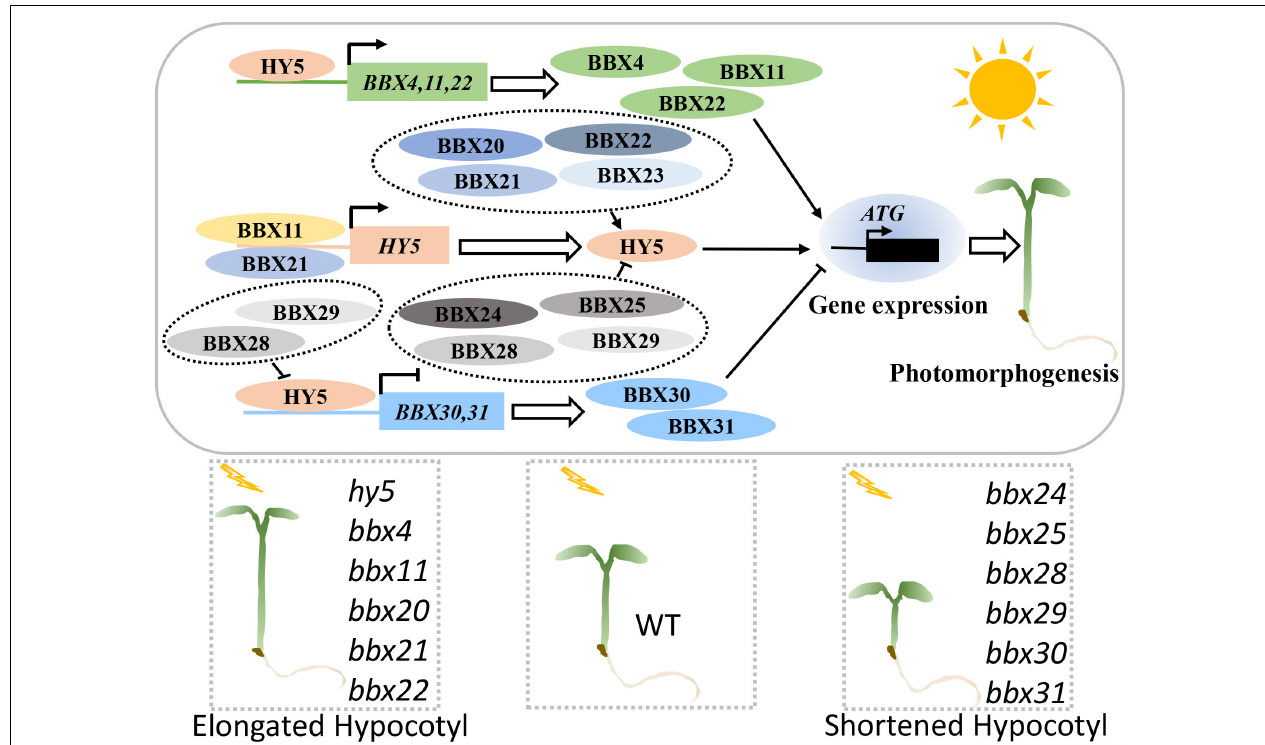
FIGURE 3 | BBX-HY5 regulatory module promotes photomorphogenesis. BBXs and HY5 form a complex transcriptionally regulatory network in promoting photomorphogenesis. HY5 activates the expression of BBX4 , BBX11, and BBX22 . BBX11 and BBX21 positively control the transcription of HY5 . BBX20, BBX21, BBX22, and BBX23 form heterodimers with HY5 to enhance its activity, whereas BBX24, BBX25, BBX28, and BBX29 interact with HY5 to inhibit its transcriptional activation activity. BBX28 and BBX29 inhibit the HY5 action to upregulate BBX30 and BBX31 at the transcriptional level. Together, these events synergistically serve to control HY5-mediated genes to promote photomorphogenesis. HY5, BBX4, BBX11, BBX20, BBX21, and BBX22 are positive regulators of light signaling, while BBX24, BBX25, BBX28, BBX29, BBX30, and BBX31 negatively regulate